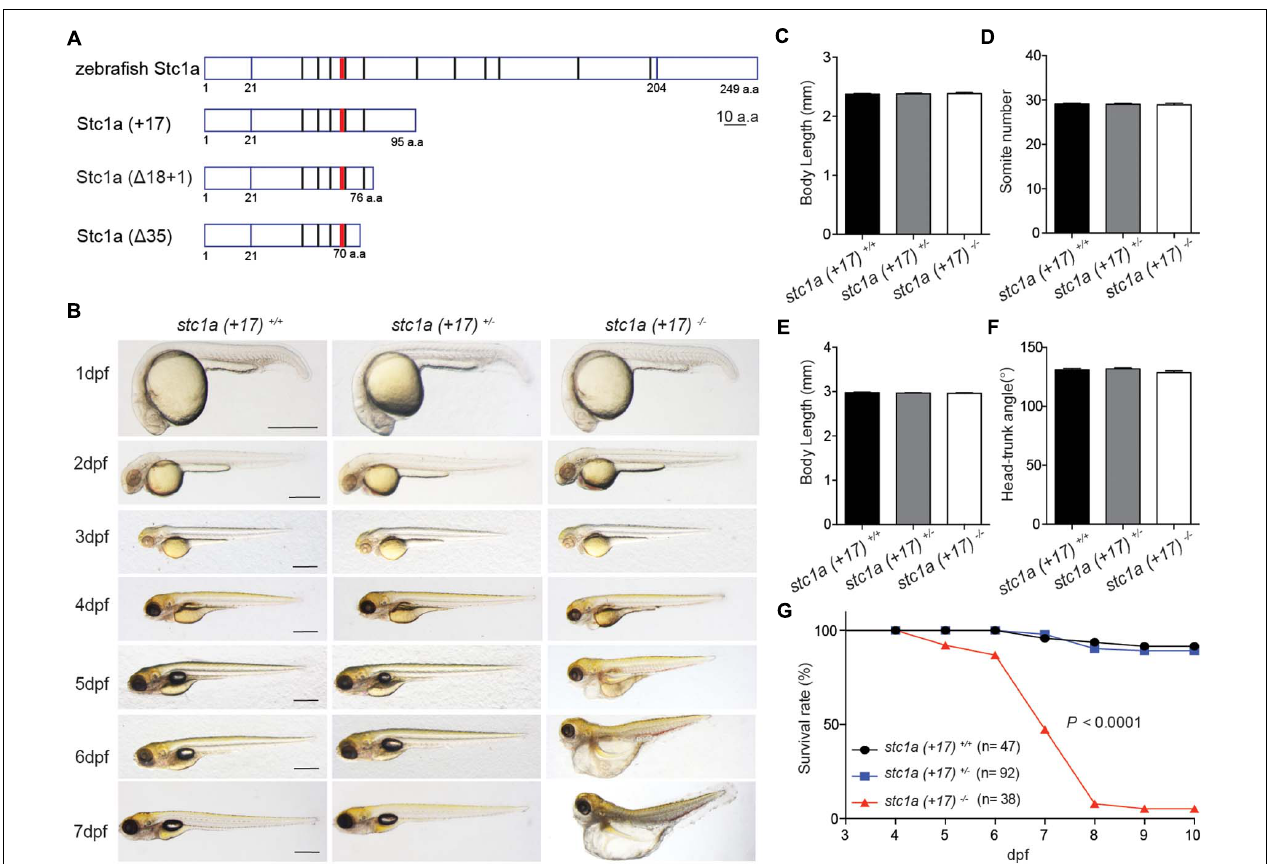
FIGURE 2 | Genetic deletion of stc1a results in cardiac edema, body swelling, and premature death. (A) Schematic diagram of Stc1a protein and the indicated mutants. The N-linked glycosylation site and conserved cysteine residues are shown by red and black bars, respectively. (B) Morphology of fish of the indicated genotypes at the indicated stages. Lateral views with anterior to the left and dorsal up. Scale bar = 0.5 mm. (C–F) Body length, somite number, and head-trunk angle of the indicated genotypes at 24 hpf (C,D) and 48 hpf (E,F) . n = 15–42 fish/group. (G) Survival curves. Progenies of stc1a ( + 17) + / − intercrosses were raised in E3 embryo medium. Dead embryos were collected daily and genotyped individually. The survival curves of indicated genotypes and the total fish numbers are shown. P < 0.0001 by log-rank test.